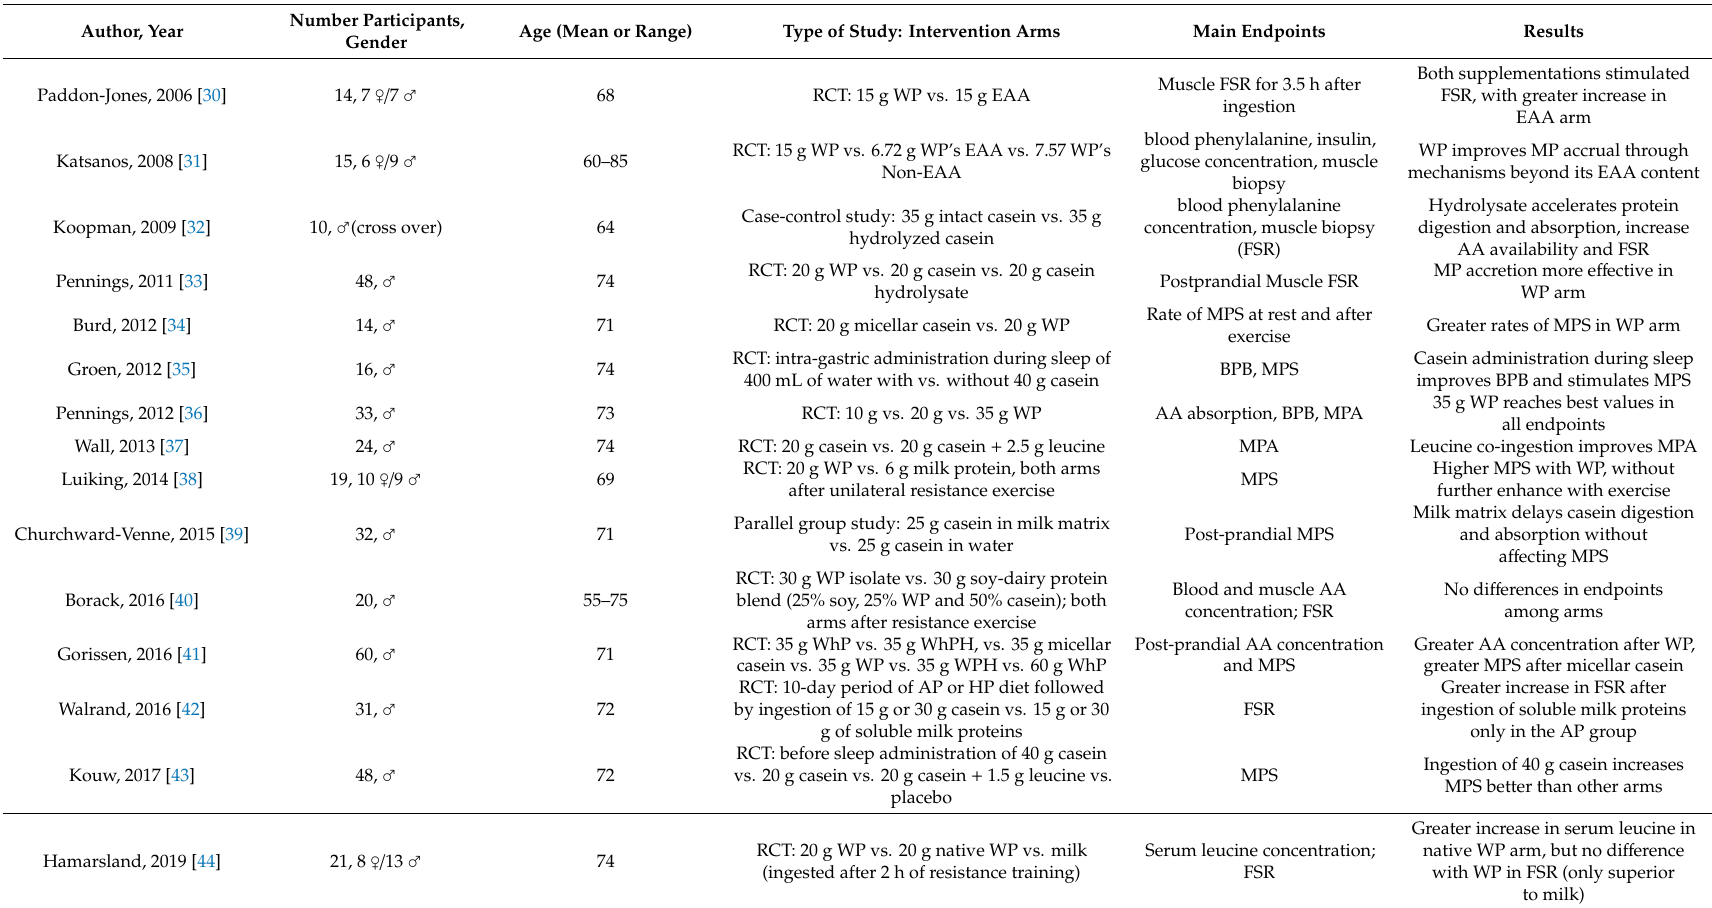
Table 1. Studies aimed to identify the best protein supplementation in inducing muscle protein synthesis or accretion, after acute